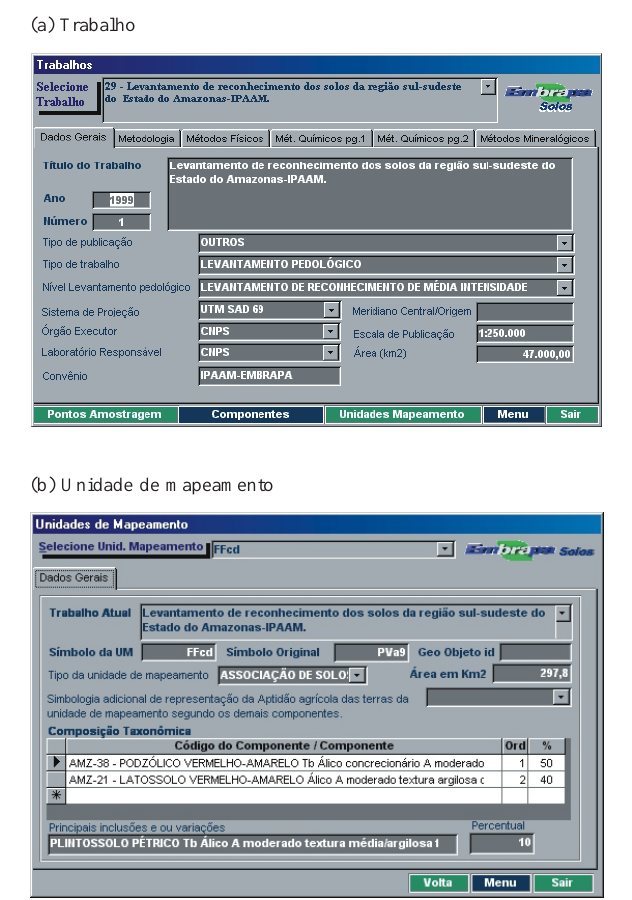
Figura 5. Tela principal da entidade trabalho.